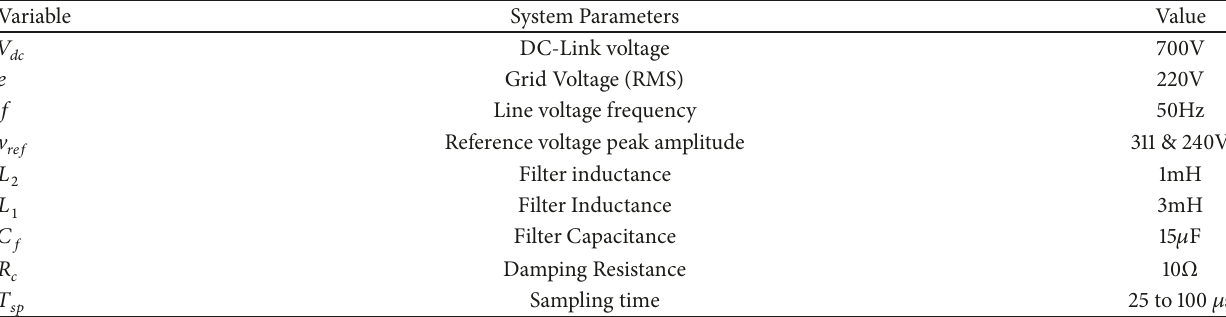
Table 1: Parameters used for the simulation and